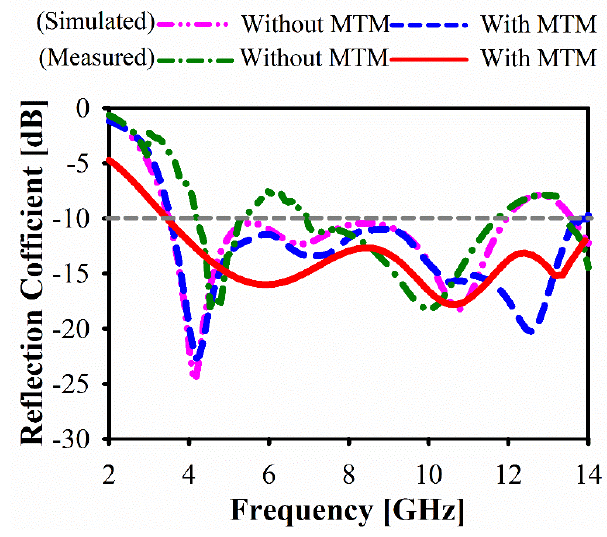
Figure 14. Simulated and measured reflection coefficient ( S 11 ).